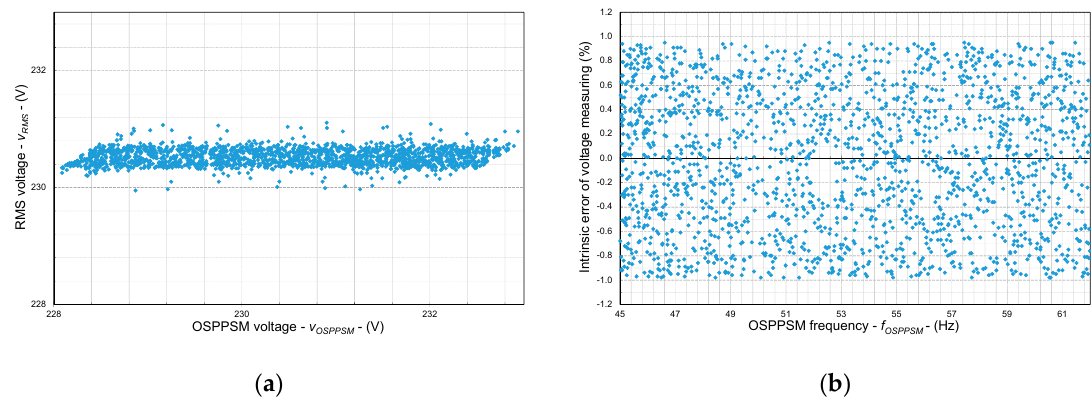
Figure 17. Voltmeter test: ( a ) OSPPSM vs. RMS voltage. ( b ) Intrinsic error of voltage measuring.